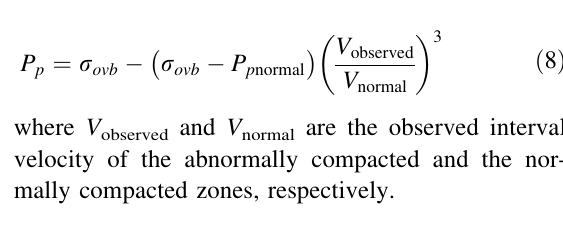
Fig. 8 Pore pressure gradient for CDP 120 along inline